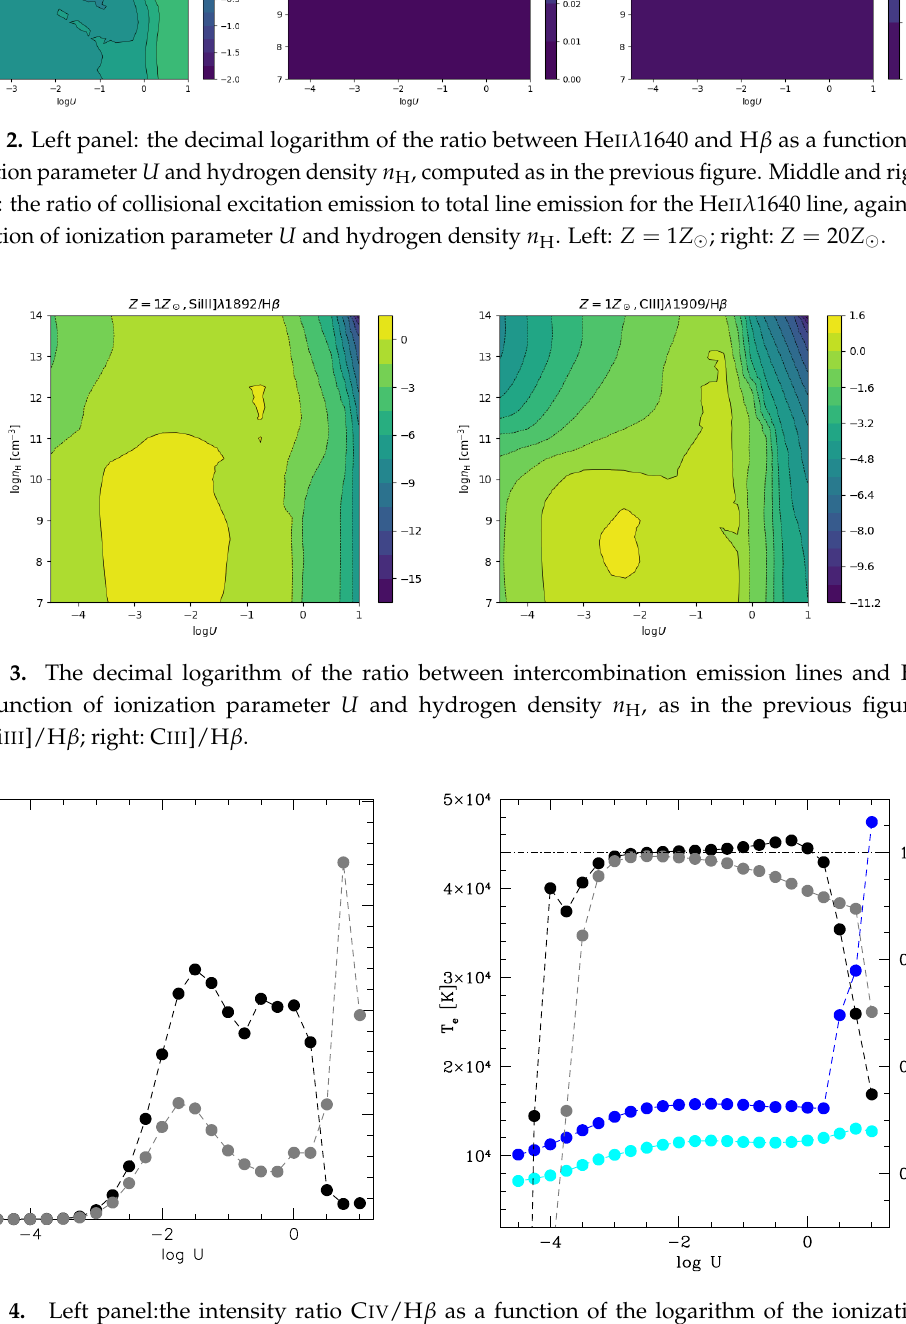
Figure 4. Left panel:the intensity ratio C IV /H β as a function of the logarithm of the ionization parameter, for n H = 10 9 cm − 3 , for Z = 1 Z (cid:12) (black dots) and Z = 20 Z (cid:12) (grey dots), assuming log N c = 23 (cm − 2 ). Right: average electron temperature (blue) over the radius of the C IV emitting zone in the gas slab and R c of C IV (black) as a function of the logarithm of the ionization parameter, for Z = 1 Z (cid:12) and the same N c and n H . Cyan circles show T e and grey ones R c for Z = 20 Z (cid:12)